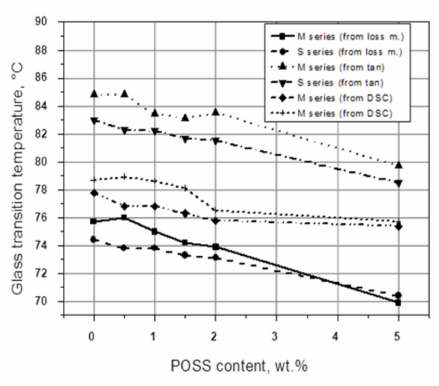
Figure 2. The Tg values from the DSC thermograms, loss modulus, and tangent δ DMTA spectra for PVC/POSS composites as a function of POSS concentration